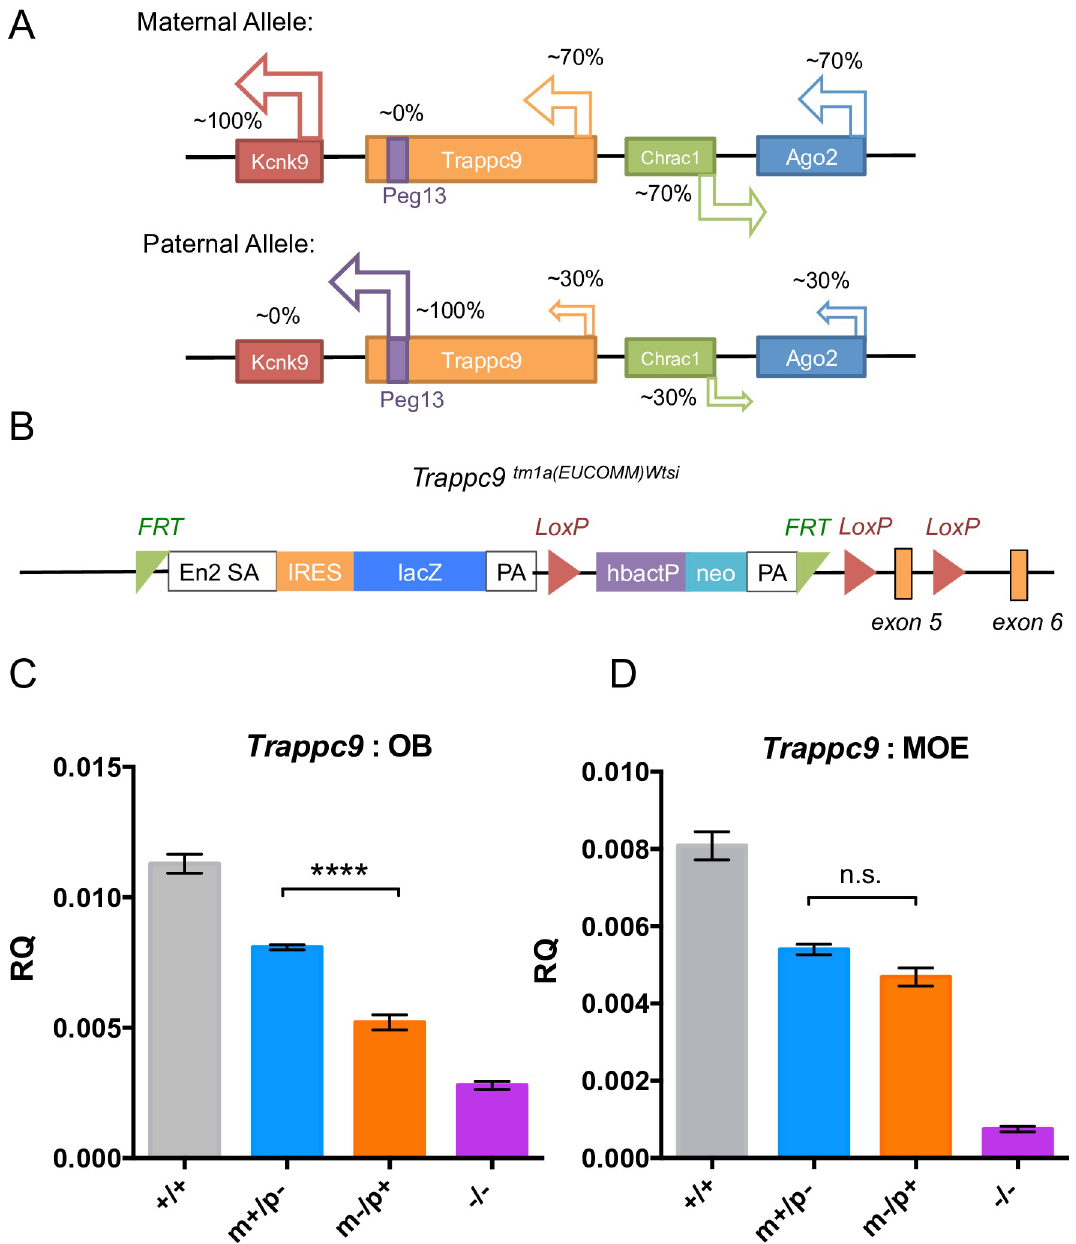
Fig 3. Generation of Trappc9 deficient mice. ( A) Schematic depiction of the Trappc9 locus and Peg13 imprinted cluster on mouse chromosome 15 with allelic biased expression indicated. ( B) Schematic view of the tm1a(EUCOMM) wtsi conditional gene-trap cassette in intron 4 of Trappc9 . ( C-D) Confirmation of maternal-biased Trappc9 expression in heterozygous Trappc9 knock-out mice ( � p < 0.05, ���� p < 0.0001, one-way ANOVA with Dunnet’s post hoc test). Trappc9 mRNA abundance was determined relative to β - actin in OB ( C) and MOE ( D) of wild-type (+/+), maternal (m-/p+) / paternal (m+/p-) heterozygous and homozygous (-/-) Trappc9 deficient mice using quantitate RT-PCR (males, n = 5 per genotype). brain. In contrast, in the MOE Trappc9 expression levels decreased by respectively 39%, 43% and 83% of wild-type levels, in the paternal, maternal and homozygous knock-outs respec- tively (Fig 3D, p > 0.05, S4 Data), reflecting a lack of Trappc9 imprinting in non-neuronal tis- sue. Trappc9 transcripts remaining in the homozygous Trappc9 knock-out (21~25%, Fig 3C)